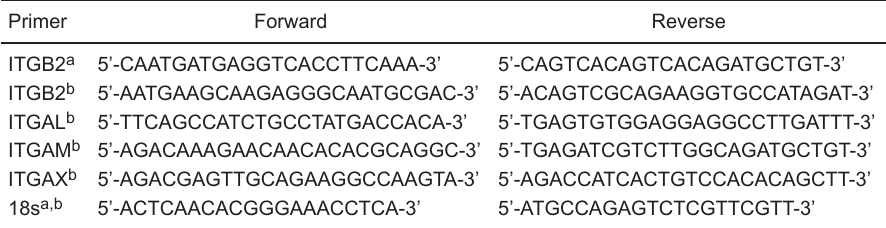
Table 1. List of real-time PCR and RT-PCR